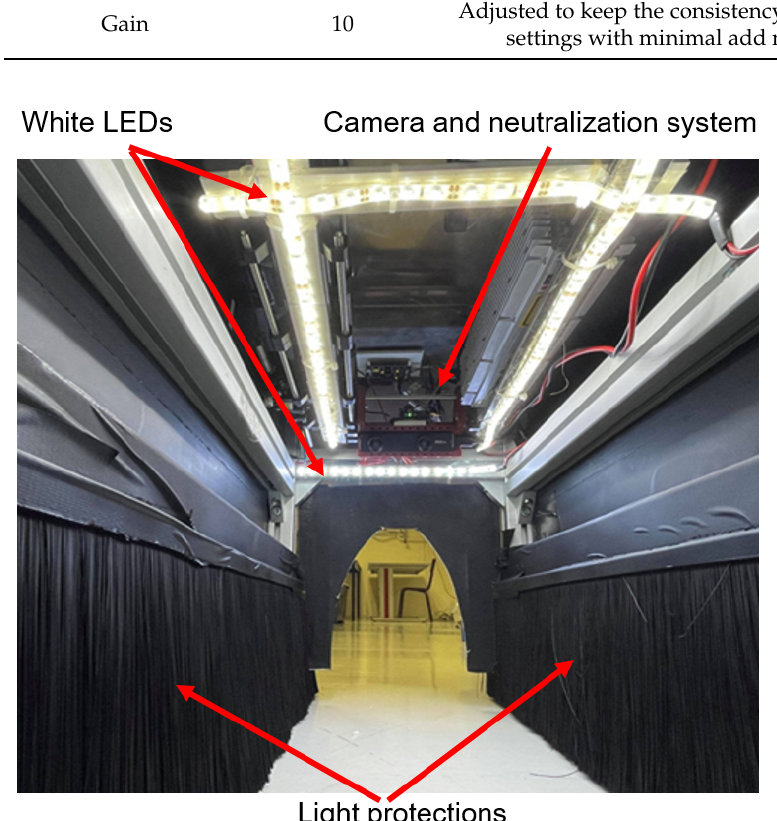
Figure 4. Under the robot: light sources and protections, camera and neutralization